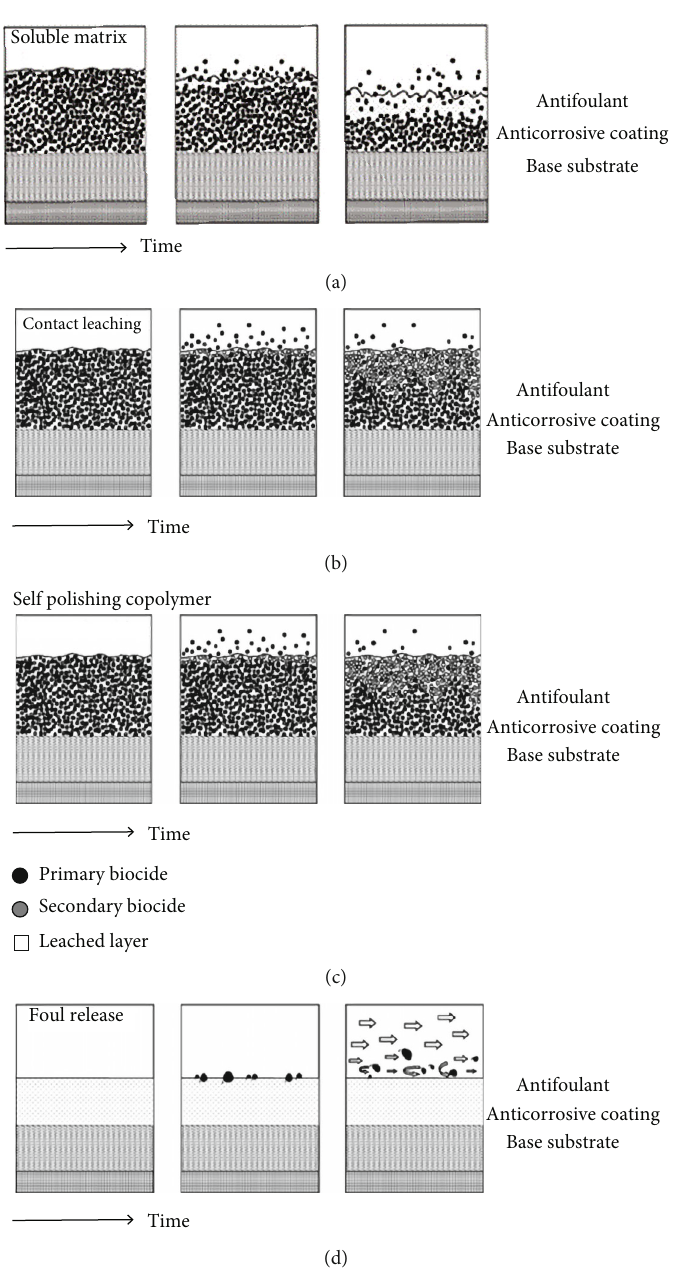
Figure 6: Schematic diagram of (a) soluble matrix, (b) contact leaching, (c) self-polishing copolymer (SPC), and (d) the release coating